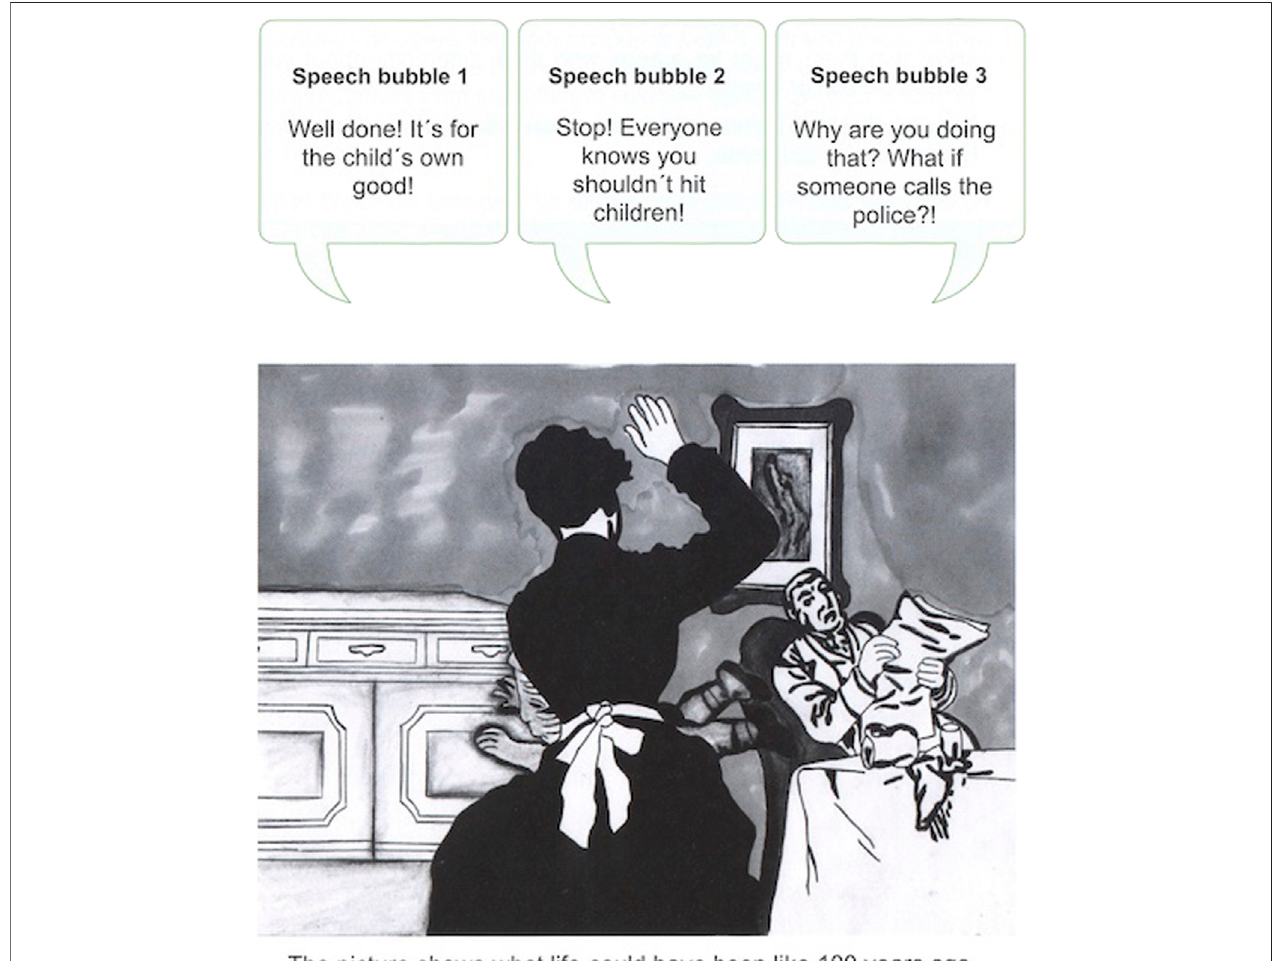
FIGURE 3 | Item no. 8 in the test from